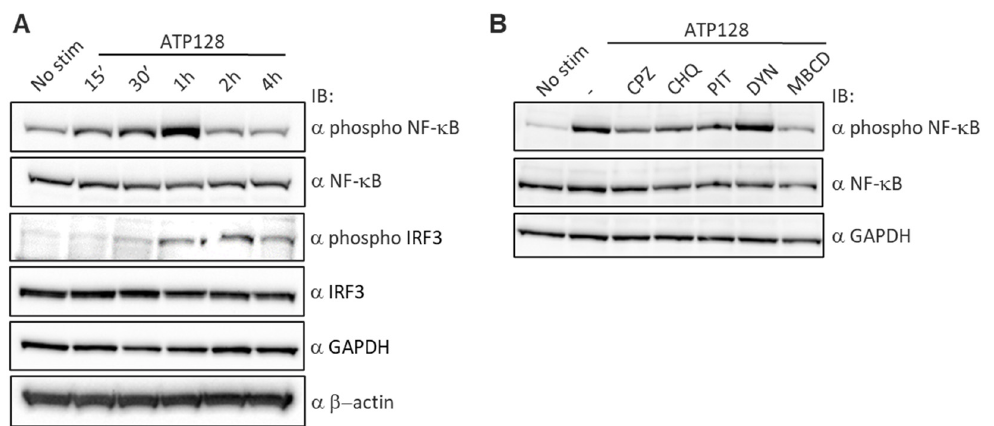
Figure 3. Extent of NF- κ B and IRF3 phosphorylation upon ATP128 stimulation. ( A ) THP-1 Dual cells were stimulated with 300 nM ATP128 at different time points and the phosphorylation of NF- κ B and IRF3 was assessed through Western blot using specific phospho-antibodies. Anti- β actin and anti-GAPDH were used as normalizers. ( B ) THP-1 Dual cells were pretreated with different endocytosis inhibitors for 1 h and then stimulated with 300 nM ATP128 for an additional hour; the phosphorylation of NF- κ B was assessed by Western blot, as described above. The uncropped blots are shown in File